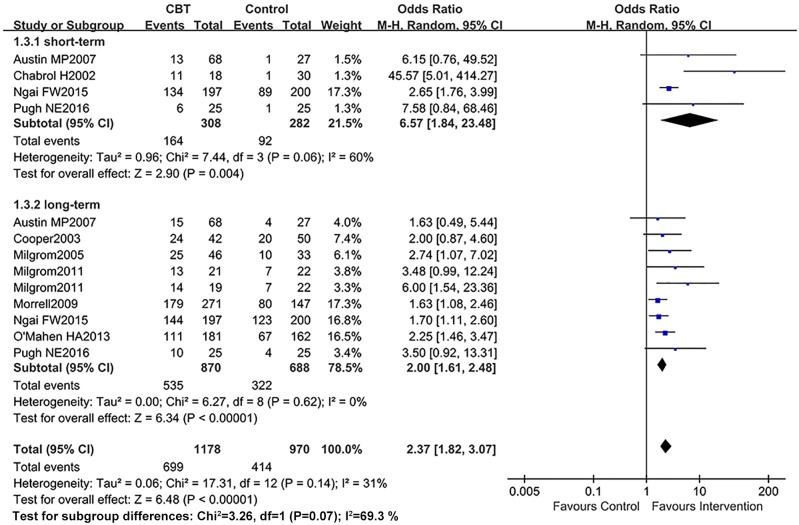
Meta-analysis of the OR in women who improved and failed to meet the diagnostic criteria (variously defined) comparing CBT with control post-intervention: A random effects analysis.